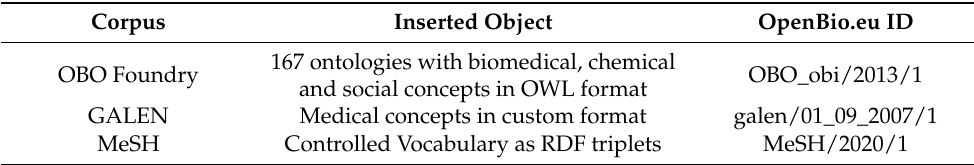
Table 3. Ontologies imported into OpenBio.eu (with unique OpenBio.eu IDs). Corpus Inserted Object OpenBio.eu ID 167 ontologies with biomedical, chemical OBO Foundry OBO_obi/2013/1 and social concepts in OWL format GALEN Medical concepts in custom format MeSH Controlled Vocabulary as RDF